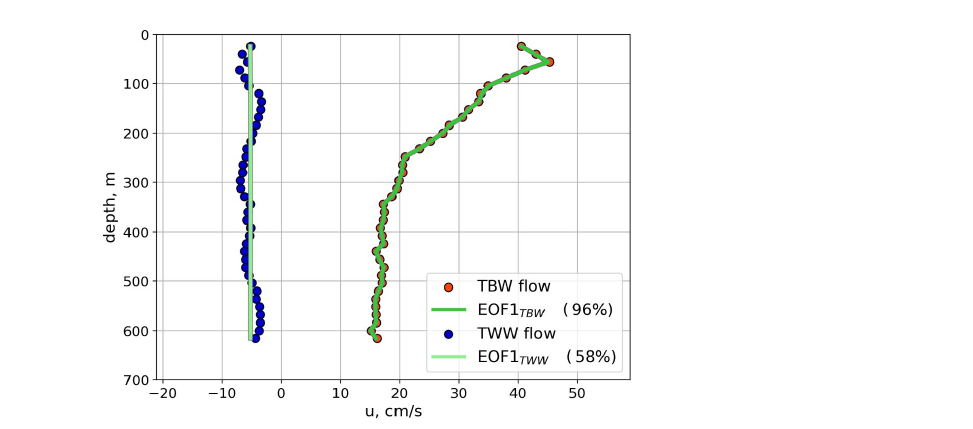
FIGURE 9 The averaged SADCP along-strait velocity pro fi le in the BC (red dots) and CC (blue dots). Their fi rst EOFs are shown by green and light green lines, respectively. The EOF fi rst modes were scaled to match the mean speed pro fi les. The percentage of variability explained by the fi rst empirical mode are shown in